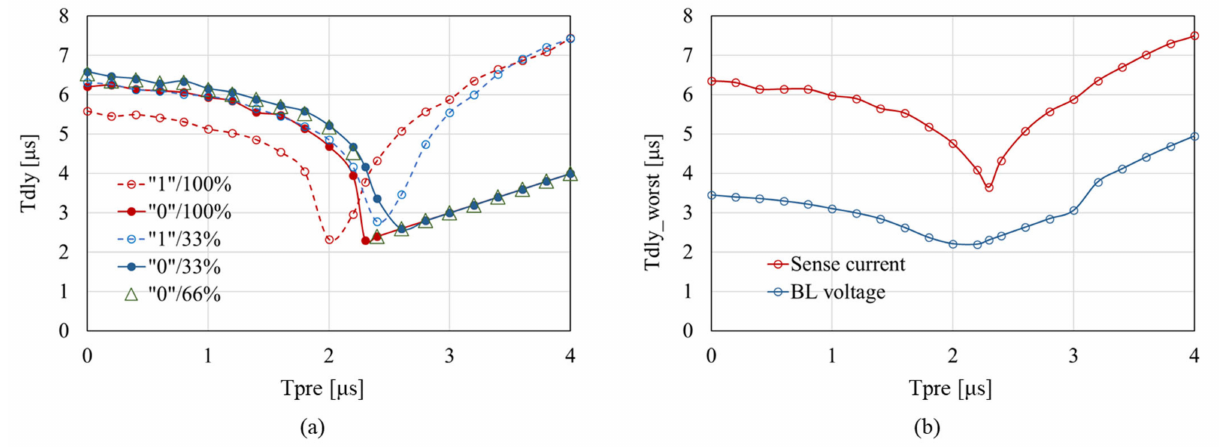
Figure 4. ( a ) Sensed current delay at different BL positions. ( b ) Worst delay time in all BL positions for the sensed current and BL voltage.